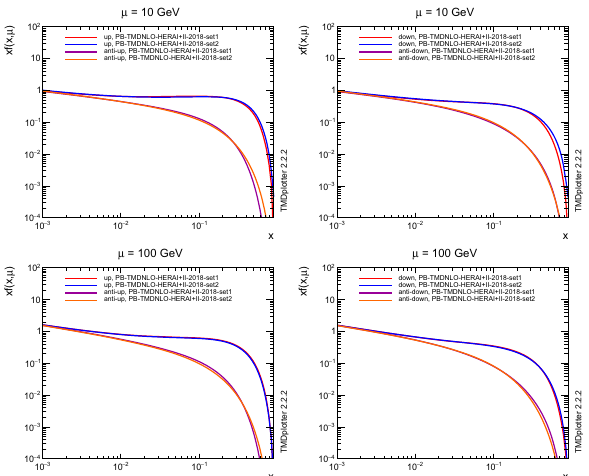
Fig. 1 Collinear parton distributions for up and down quarks (PB- NLO-2018-Set1, PB-NLO-2018-Set 2) as a function of x at μ = 10 and 100 GeV